Question: Write the caption for this figure.
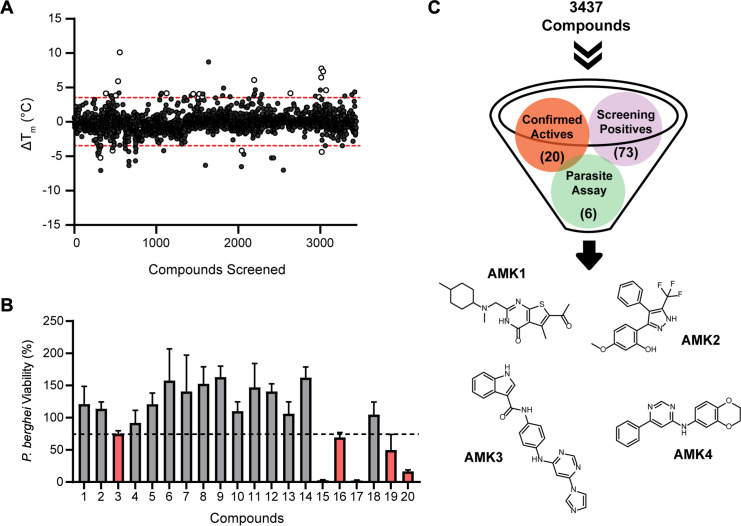
Answer: High-throughput screen identifies molecules that bind to Pf Hsp70-1. ( A ) Change in melting temperature (Tm) of Pf Hsp70-1 with the addition of 3,437 compounds relative to DMSO. Threshold for actives was a Tm change of ≥3.5°C (red dashed line). Actives were confirmed through a 5-point dose-response curve (open circles). ( B ) Confirmed actives (compounds 1–20 at 10 µM) were tested for inhibition of P. berghei liver stage parasites, identifying six compounds (red bars) that reduced parasite load (black dashed line denotes 25% inhibition). Data shown as the average ± SEM ( n = 3). ( C ) Summary of the TSA screening strategy that identified four hits (AMK1–4).